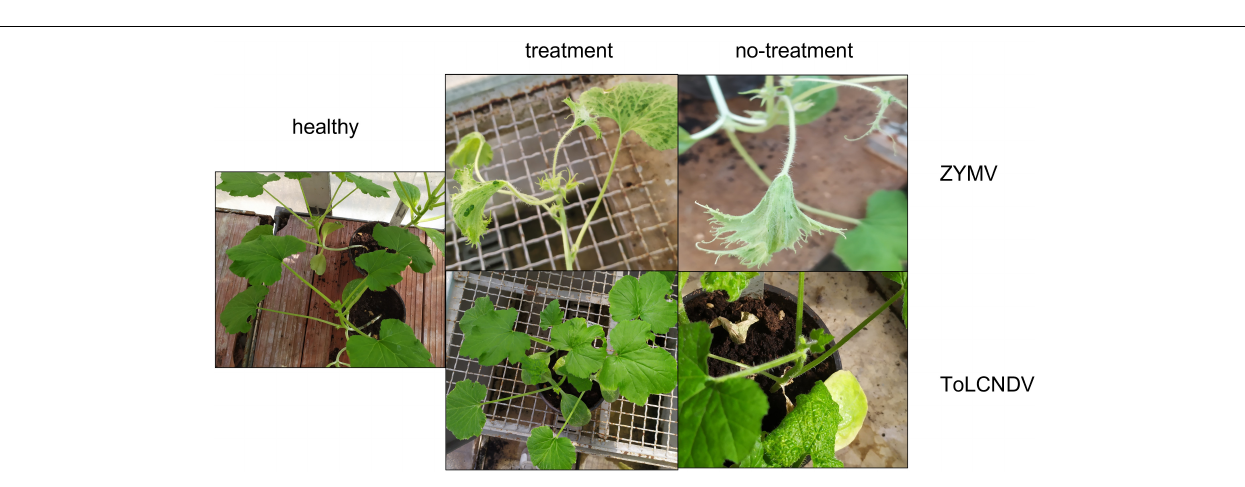
FIGURE 3 | Visual inspection of plants treated together with inoculation of ZYMV or ToLCNDV: one example treatment and the relevant no-treatment is shown for each